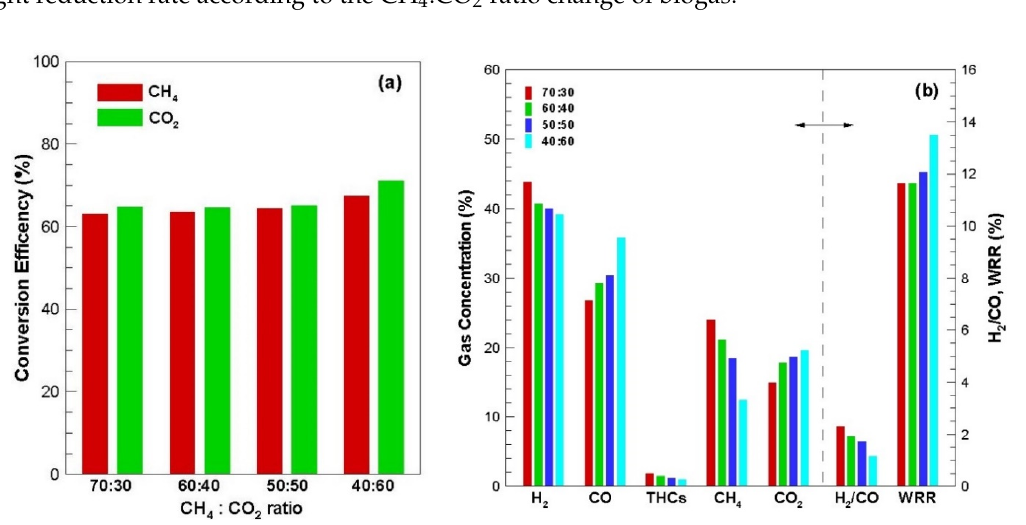
Figure 4. Characteristics of biogas reforming. ( a ) CH 4 and CO 2 conversion efficiencies and ( b ) H 2 /CO ratio, weight reduction rate and product gas average concentration.